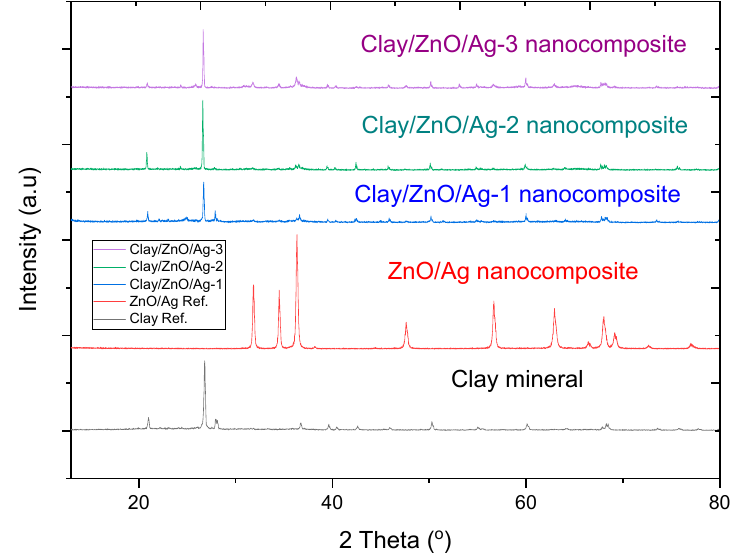
Figure 10. XRD spectra pattern of clay mineral, ZnO / Ag, clay / ZnO / Ag. Clay / ZnO / Ag-1, clay / ZnO / Ag-2, clay / ZnO / Ag-3 have 2.5%, 5% and 10% of ZnO / Ag, respectively.